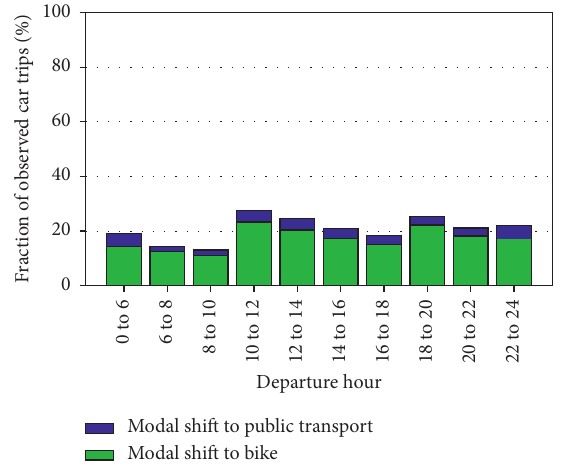
Figure 12: Observed car trips with a time-relevant low-carbon alternative, depending on departure time during the day.